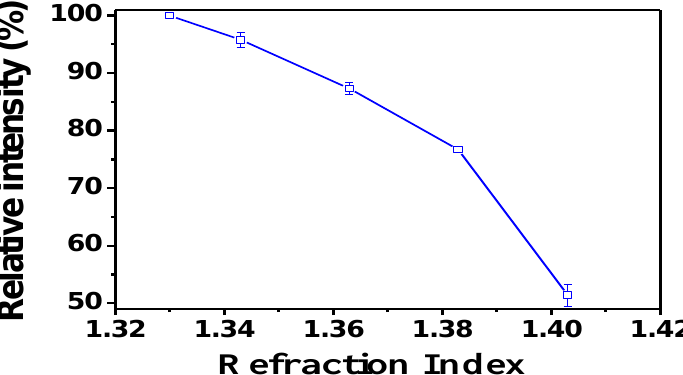
Figure 4. Plot of relative intensity versus refraction index (RI) of the medium obtained with Au-nanoparticle modified PMMA fiber in the configuration of SiO sensing probe.